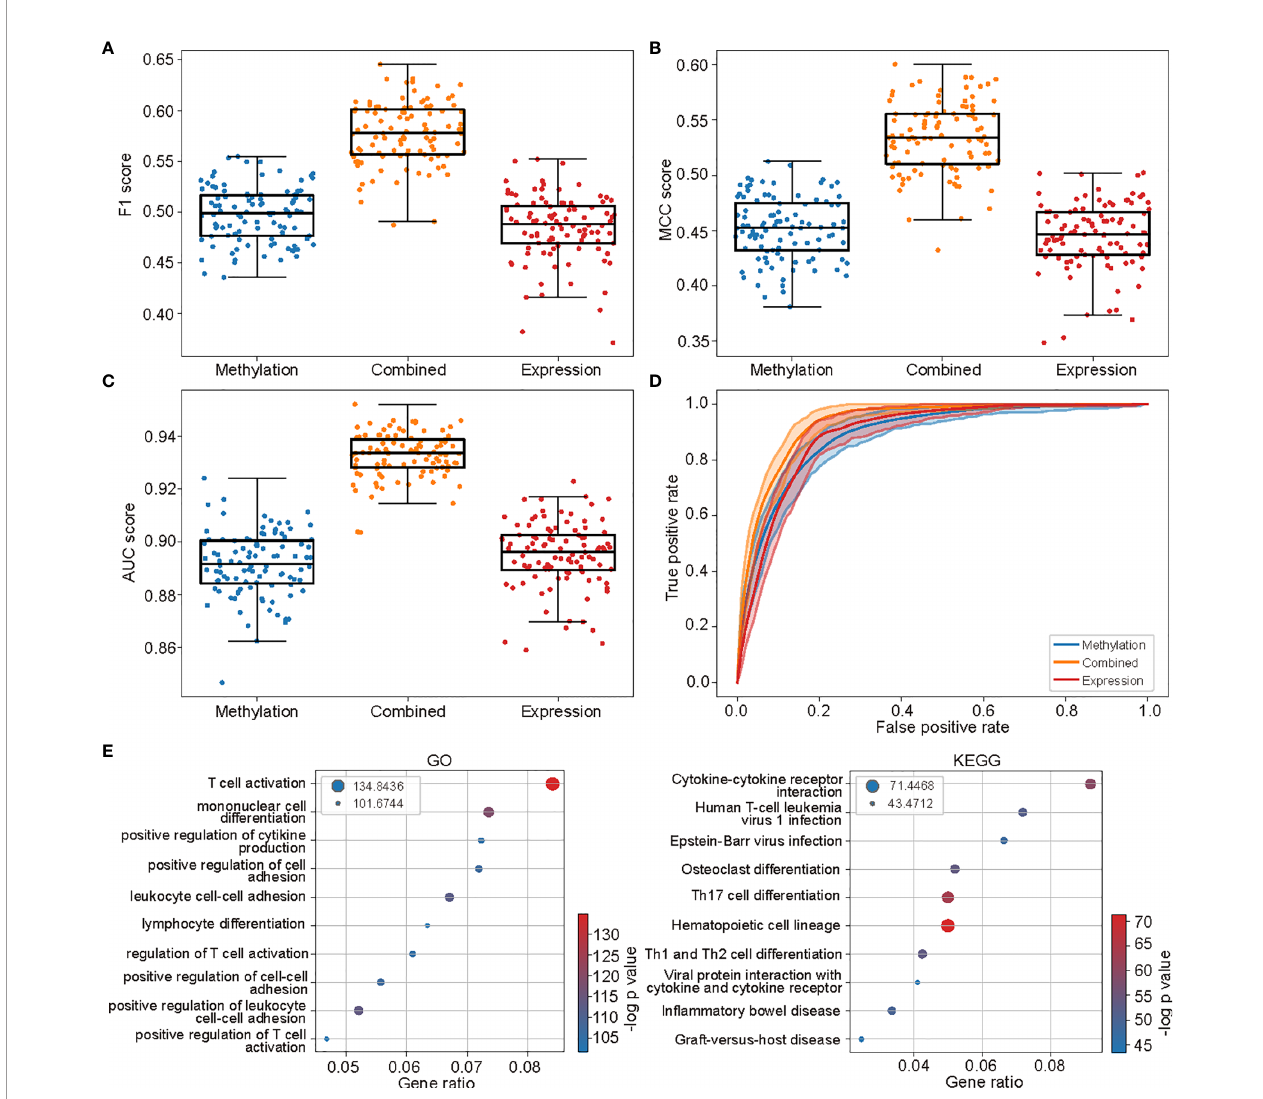
FIGURE 4 | The methylation-based model was comparable and complementary to the gene expression based one. (A – C) The performances of models based on methylation levels, the expression levels, and the combination of the two along the 100 times random split of the whole cohort into 80% trainings and 20% testing sets. (D) The ROC curves of the three models. The shades were 95% con fi dence intervals along the 100 times splits. (E) The top 10 enriched GO (left) and KEGG (right) terms of the genes involved in gene expression – based